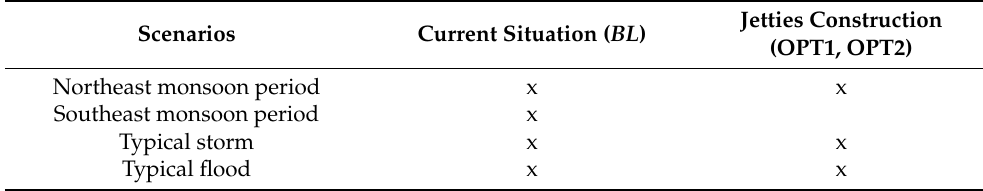
Table 2. Simulation